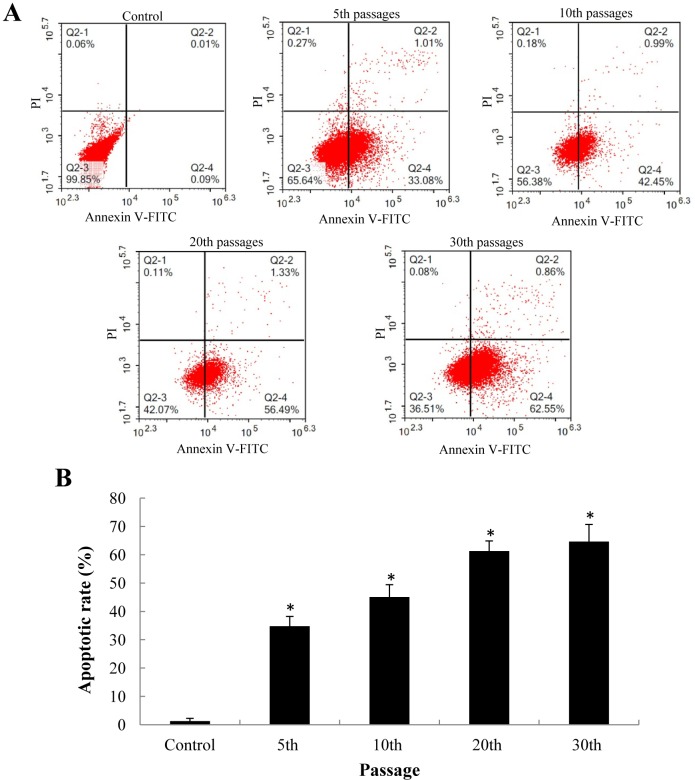
Apoptosis of BEAS-2B cells after exposure to SiNPs at the 5th, 10th, 20th, 30th passage.(A) Apoptotic populations of cells double-stained with PI- and FITC-labled Annexin V using flow cytometry. (B) SiNPs increased the apoptosis rate in a passage-dependent manner. Data are expressed as means ± S.D. *p<0.05compared with control group.